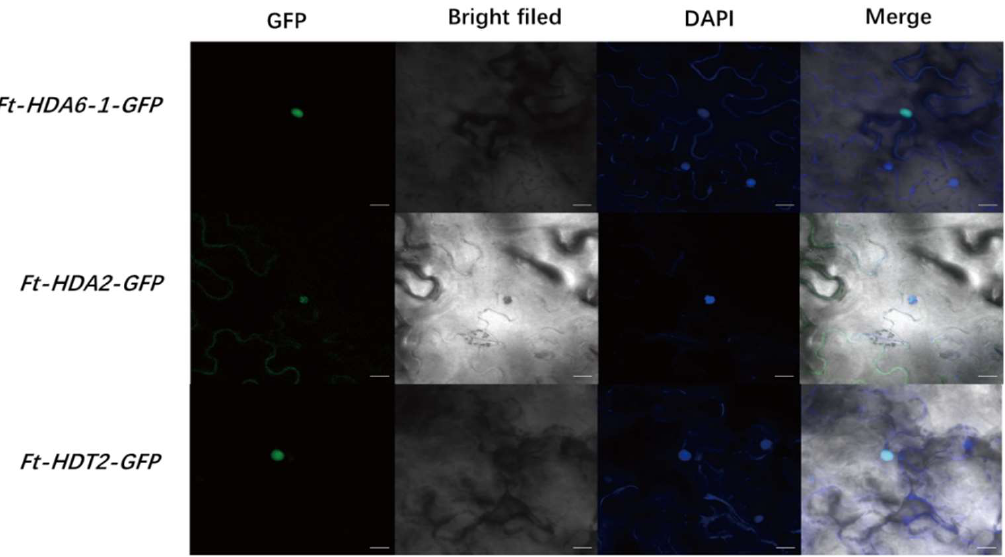
Figure 7. The subcellular localization of FtHDA6-1, FtHDA2 and FtHDT2. Bars = 20 μm.